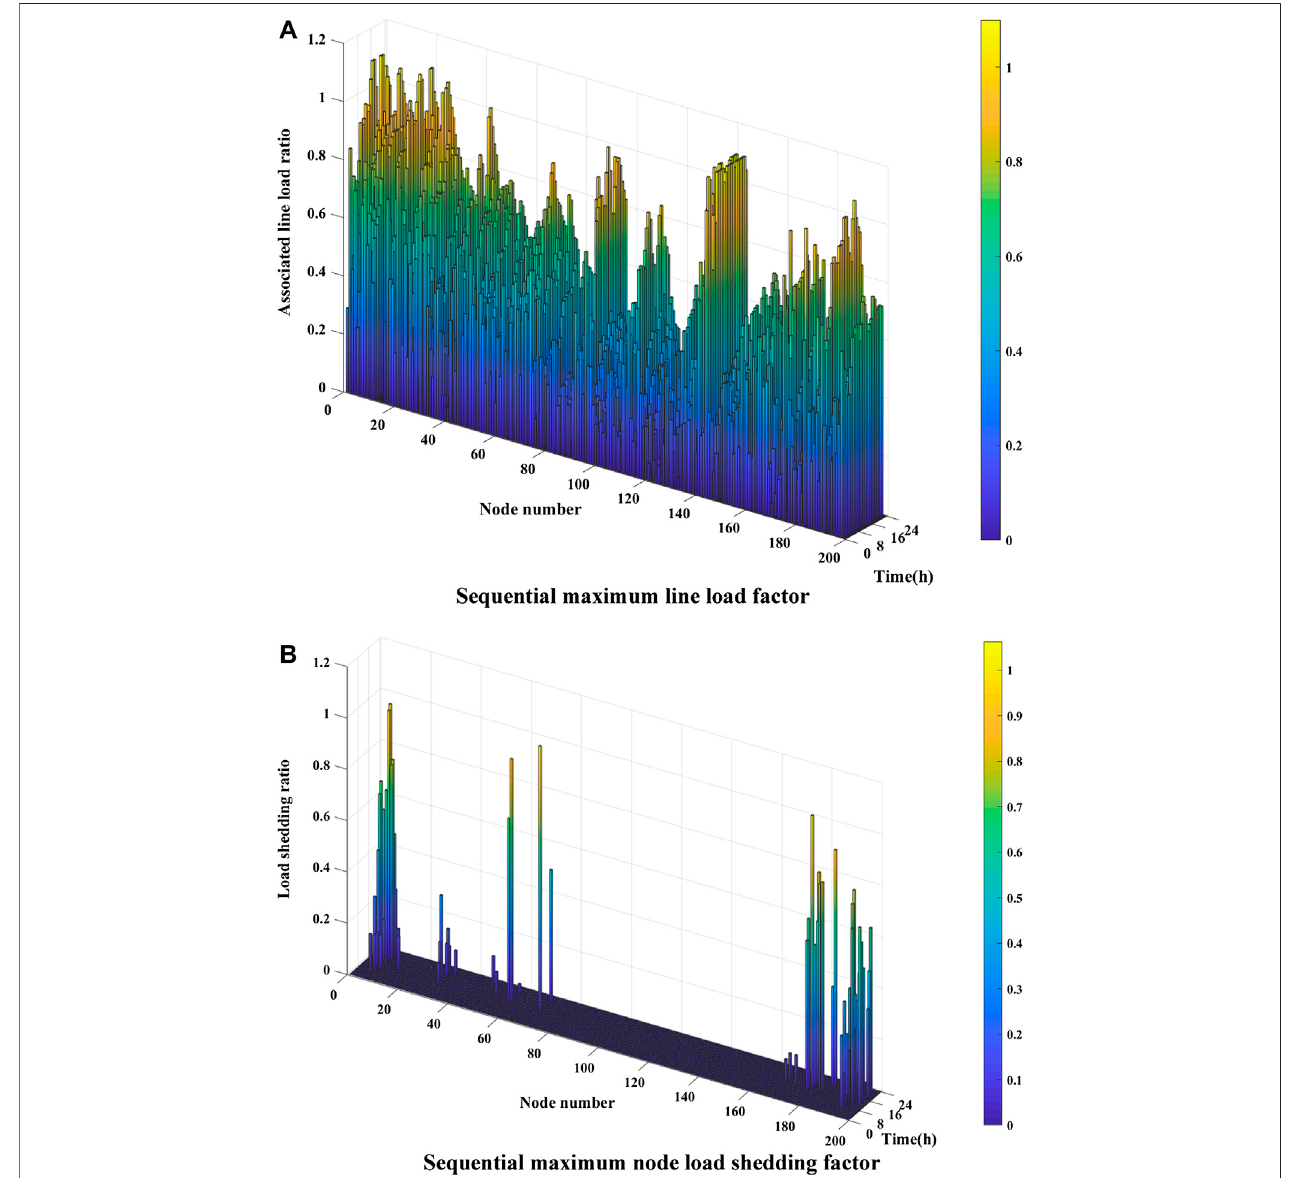
FIGURE 7 | Sequential technical indices for energy storage system siting. (A) sequential maximum line load factor. (B) sequential maximum node load shedding factor.